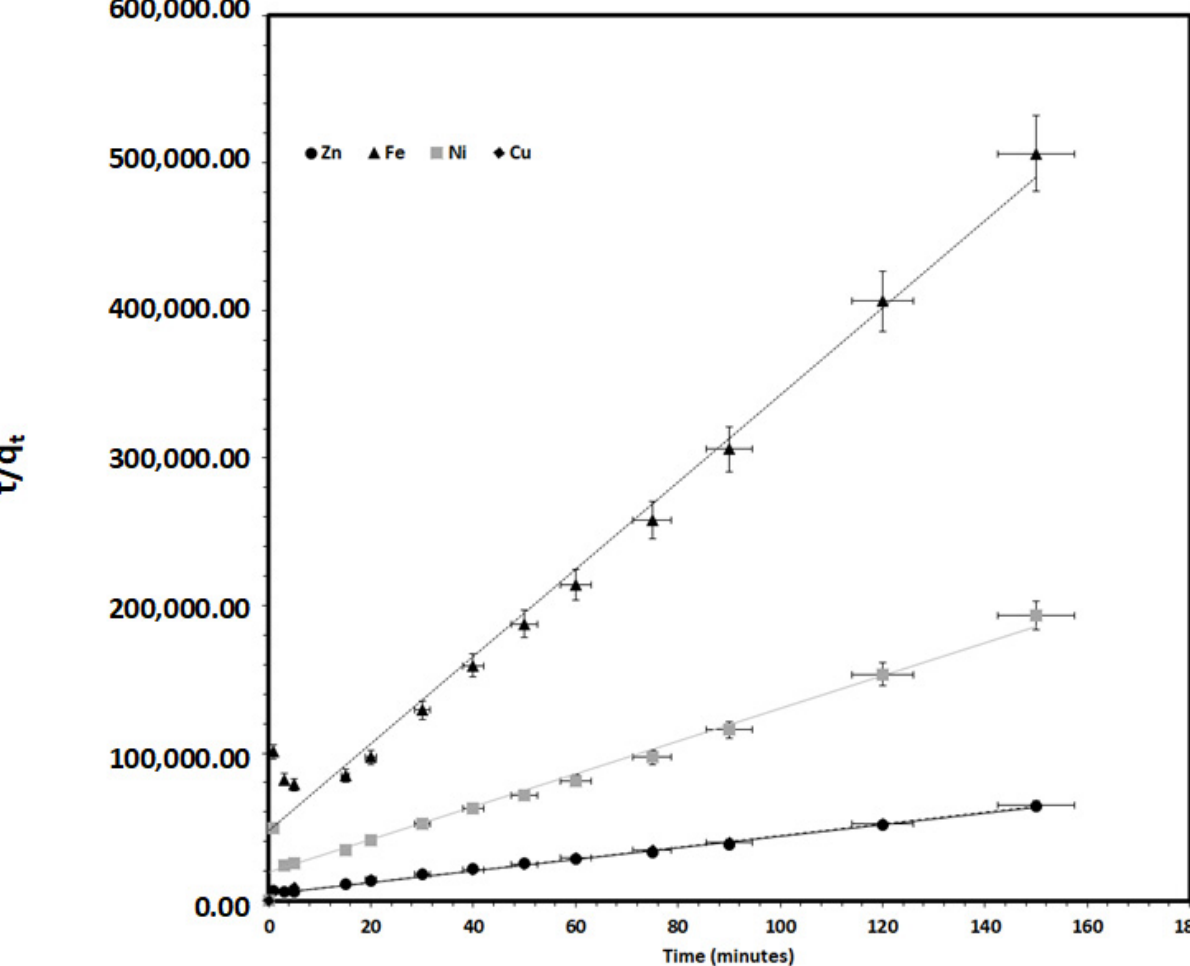
Figure 12. The applications of the PSO kinetic model for the removal of Zn, Fe, Ni, Cu ions from a desalination plant outfall brine discharge by HS nanoclay. (Experimental conditions: 60.0 mL solution, pH 8.0, 150 mg dosage, and 298 K).